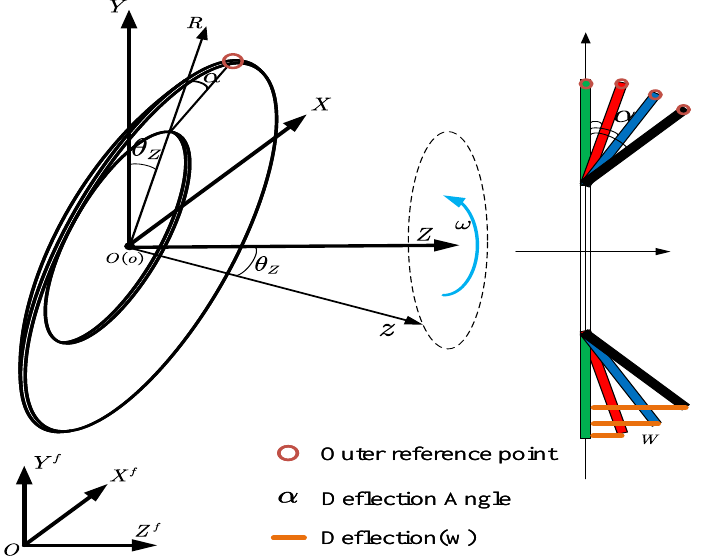
Figure 5. Deformation of spinning